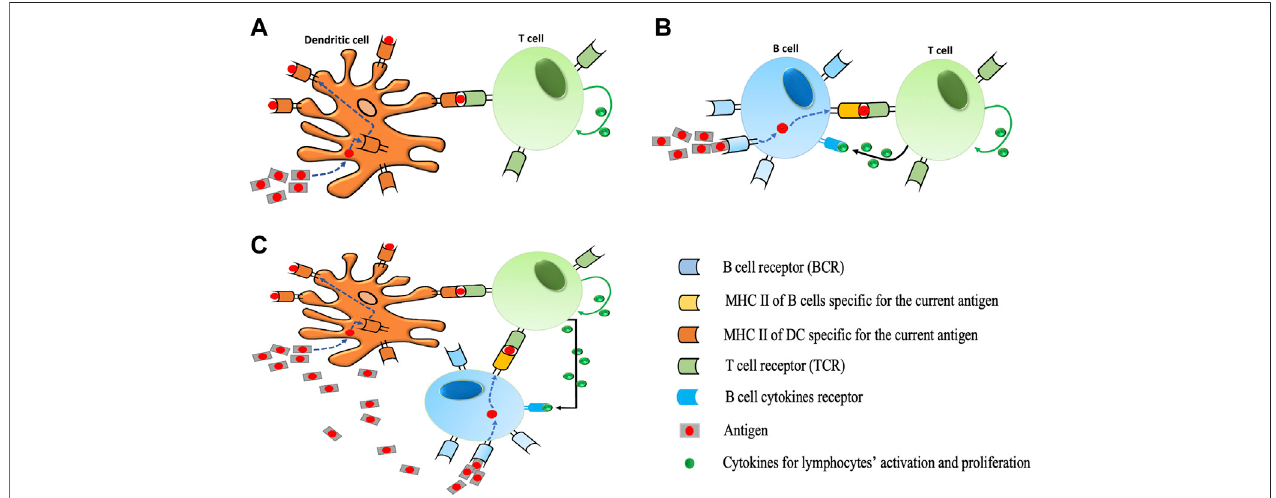
FIGURE1| Differentprotocols forTcellactivation. (A) Duringdendriticcellactivation, dendriticcells(DCs) takeupantigens,process themintoshort peptides, and present these on MHCs on their surfaces. The interaction between the T cell receptor (TCR) and the peptide-MHC complex (pMHC) at the interface between the T cell and theDC isthe main event controlling thespeci fi city ofantigen recognition byTcells. T cells bindto pMHC via TCR. The proliferation ofT cellsisperformed byspeci fi c cytokines (IL-2) in our model. (B) During B cell activation, a B cell is triggered when it encounters its matching antigen. The B cell engulfs the antigen and digests it andnextdisplaystheresultingantigenfragmentsboundtoitsuniqueMHCmolecules.ThisinteractionofantigensandMHCattractsthehelpofamaturematchingTcell. Cytokines secreted by T cell activate B cells to differentiate into plasma B cells which results in the production of more antibodies. Likewise, the proliferation of B cells is performedbyspeci fi ccytokines(IL-4)inourmodel). (C) IllustrationofDCandBcellssimultaneousactivation.Inthepresenceofahighnumberofantigensintheimmune system, the activation of T cells would be triggered via both processes described in (A) and (B) .